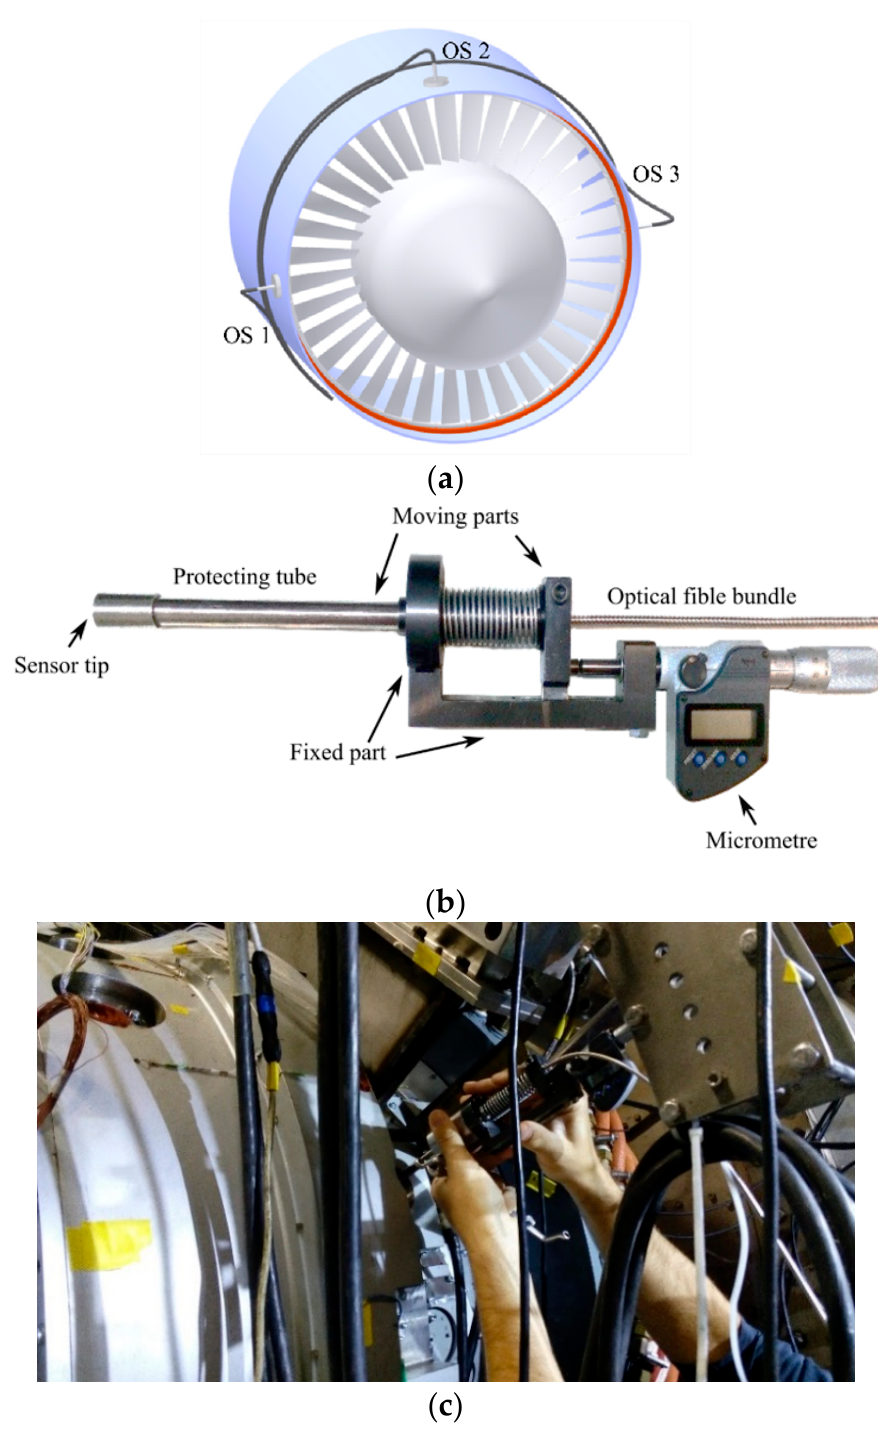
Figure 2. ( a ) Illustration of the geometrical distribution of the sensors in the turbine test rig. ( b ) Photograph of one of the ad-hoc-built micrometre-driven adapters used to insert accurately the optical probe in the casing. ( c ) Assembly of one of the optical sensors in the turbine test rig. Prior to the real tests in the wind tunnel, the sensors were calibrated in laboratory conditions (Figure